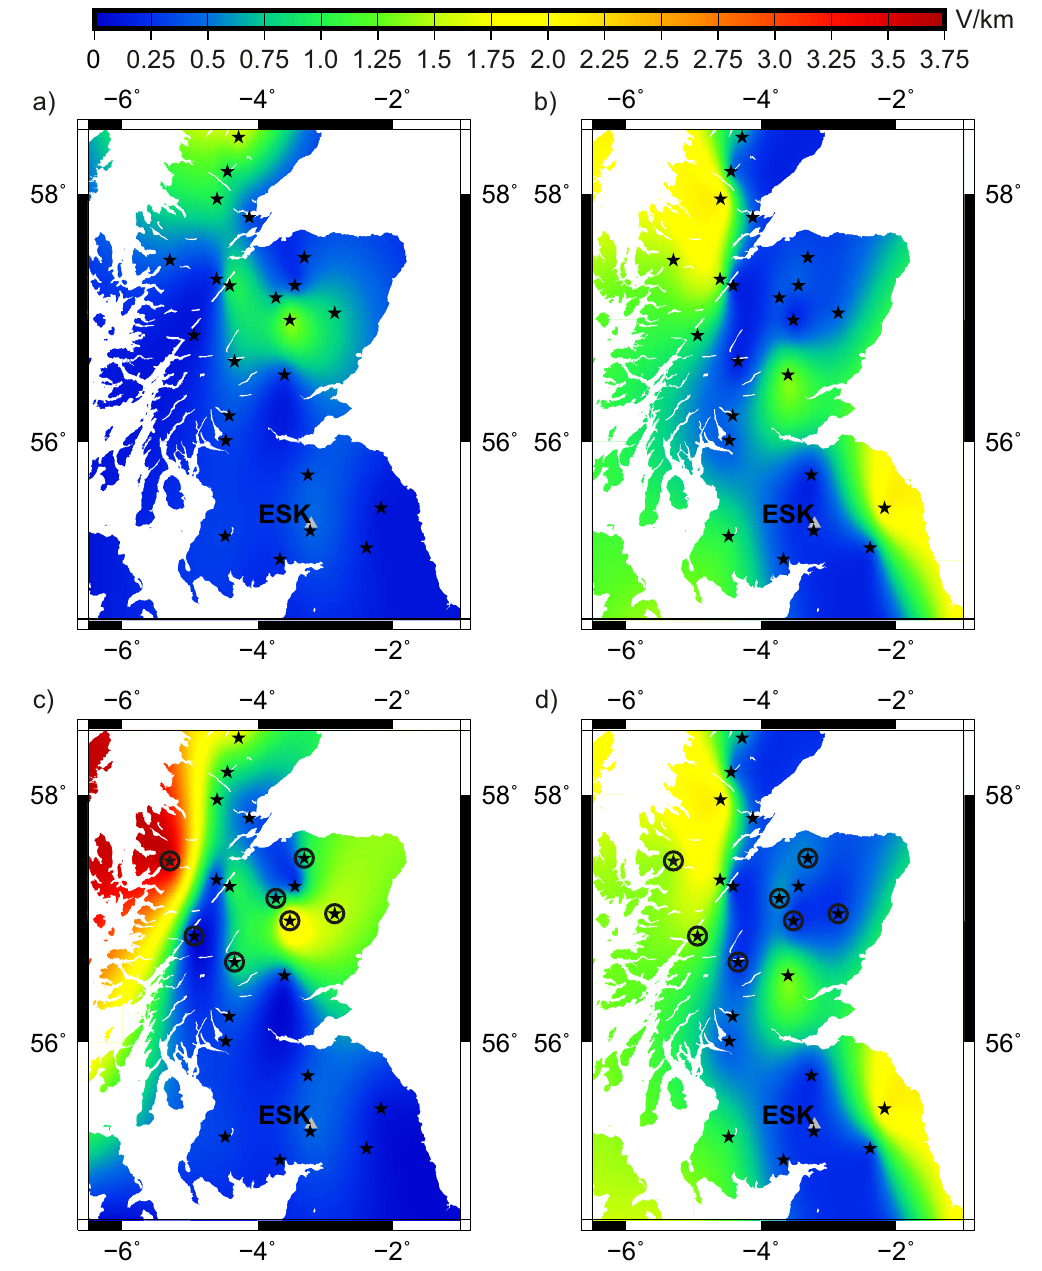
Fig. 9. Bicubic-spline interpolated (Smith & Wessel, 1990) maximum peak-to-peak electric- fi eld magnitudes at UT 01:25 during the 8th September 2017 magnetic storm for (a) E x and (b) E y polarisation using measured impedances ( Z ij ) and measured magnetic fi elds from RAN (Fig. 1); (c) E x and (d) E y polarisation with estimated electric fi elds replaced with measured storm-time electric fi elds (Simpson & Bahr, 2020b) at sites ACH, ELC, CAI, TAN, MAR, LEA and RAN (Fig. 1). Black stars indicate impedance-tensor site locations, circled stars in panel (c) and (d) indicate sites at which measured electric fi elds have been substituted for the estimated fi elds used in panels (a) and